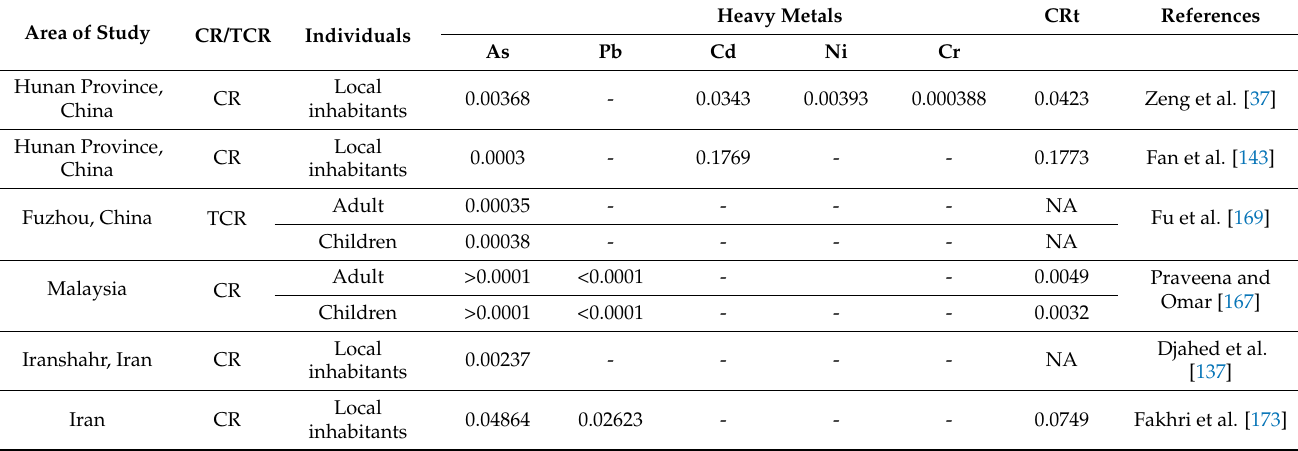
Table 6. Carcinogenic risk assessment via rice consumption in selected areas of different countries. Area of